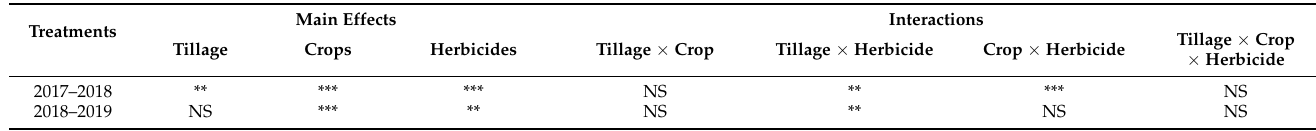
Table 4. Results of main effect and interactions from three-way ANOVA of G. coronaria dry matter for